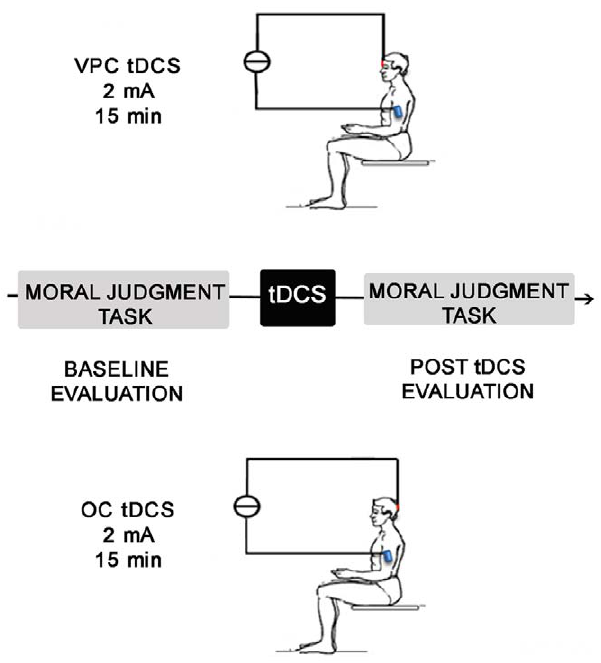
Figure 3. Experimental protocol. Subjects performed the moral judgment task before and after transcranial direct current stimulation (tDCS, 15 minutes, 2 mA) over the ventral prefrontal cortex (VPC-tDCS) or over the occipital cortex (OC-tDCS).